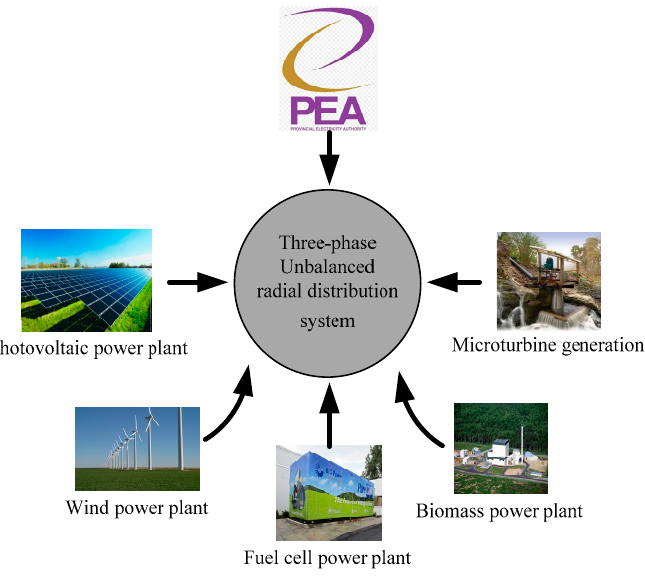
Figure 1. The connection of PEA and DG.